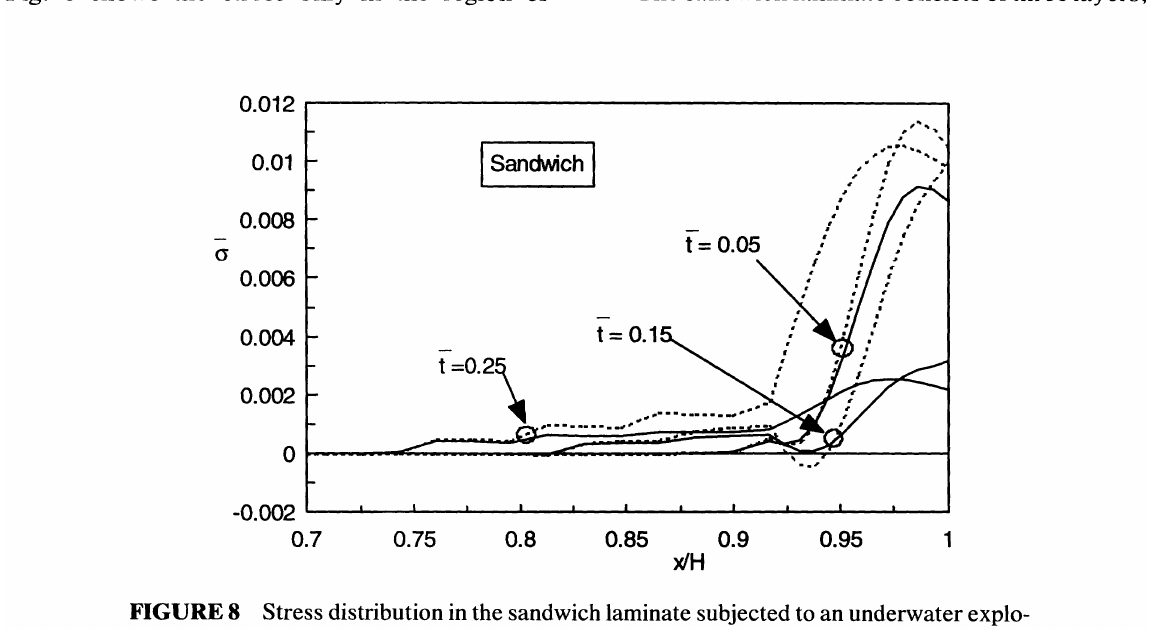
FIGURE 8 Stress distribution in the sandwich laminate subjected to an underwater explo sion: (-) wet laminate, ( ... ) dry laminate; TNT, 20 kg, D = 10